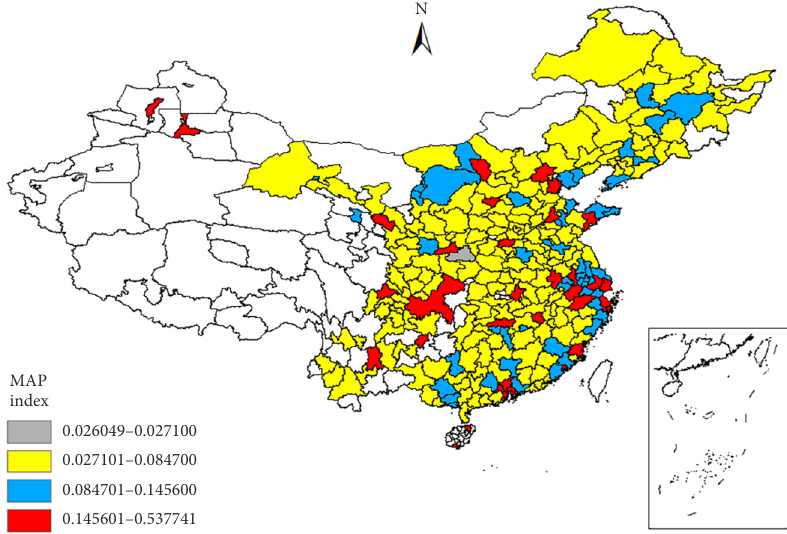
Figure 3. Types of the cities in